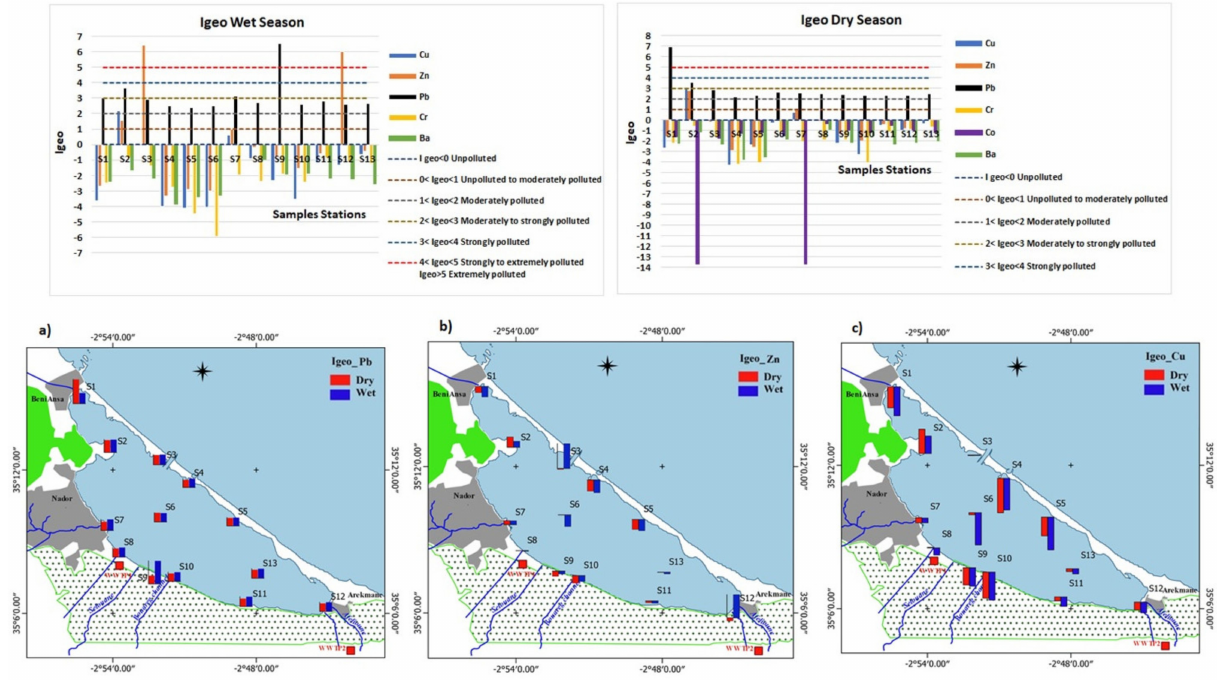
Figure 5. Wet and dry geoaccumulation index (Igeo): ( a ) Igeo of Pb; ( b ) Igeo of Zn; and ( c ) Igeo of